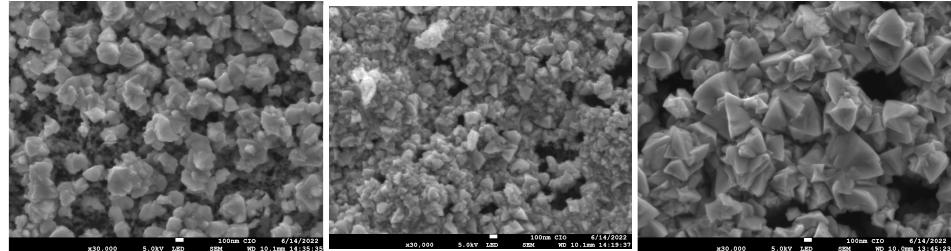
Figure 9. Micrograph SEM of samples M4, M5,